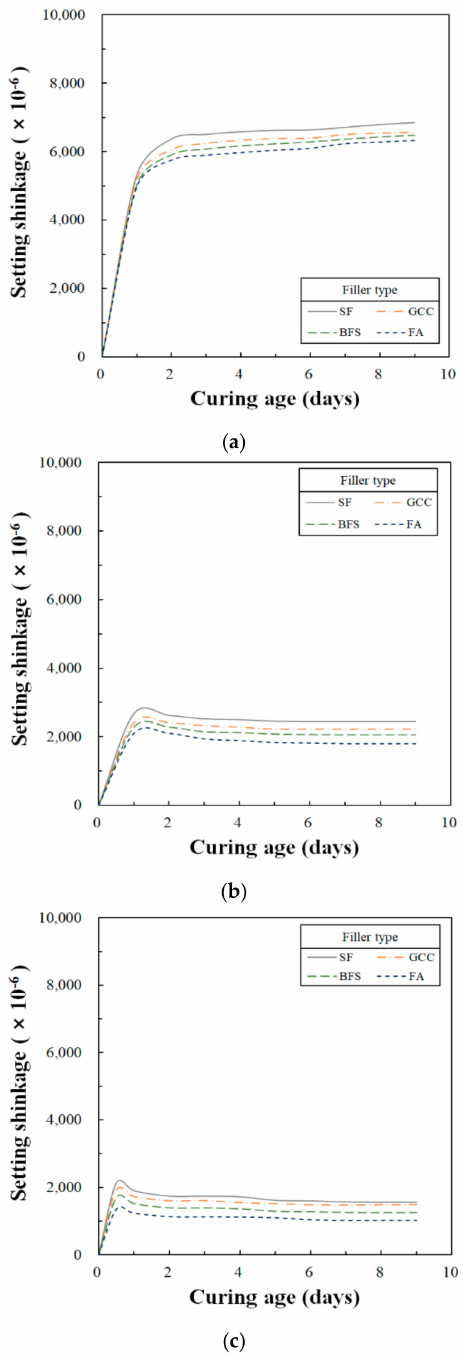
Figure 4. Variation of setting shrinkage strain as a function of curing age for type of filler: ( a ) SRA content is 0%; ( b ) SRA content is 10%; ( c ) SRA content is